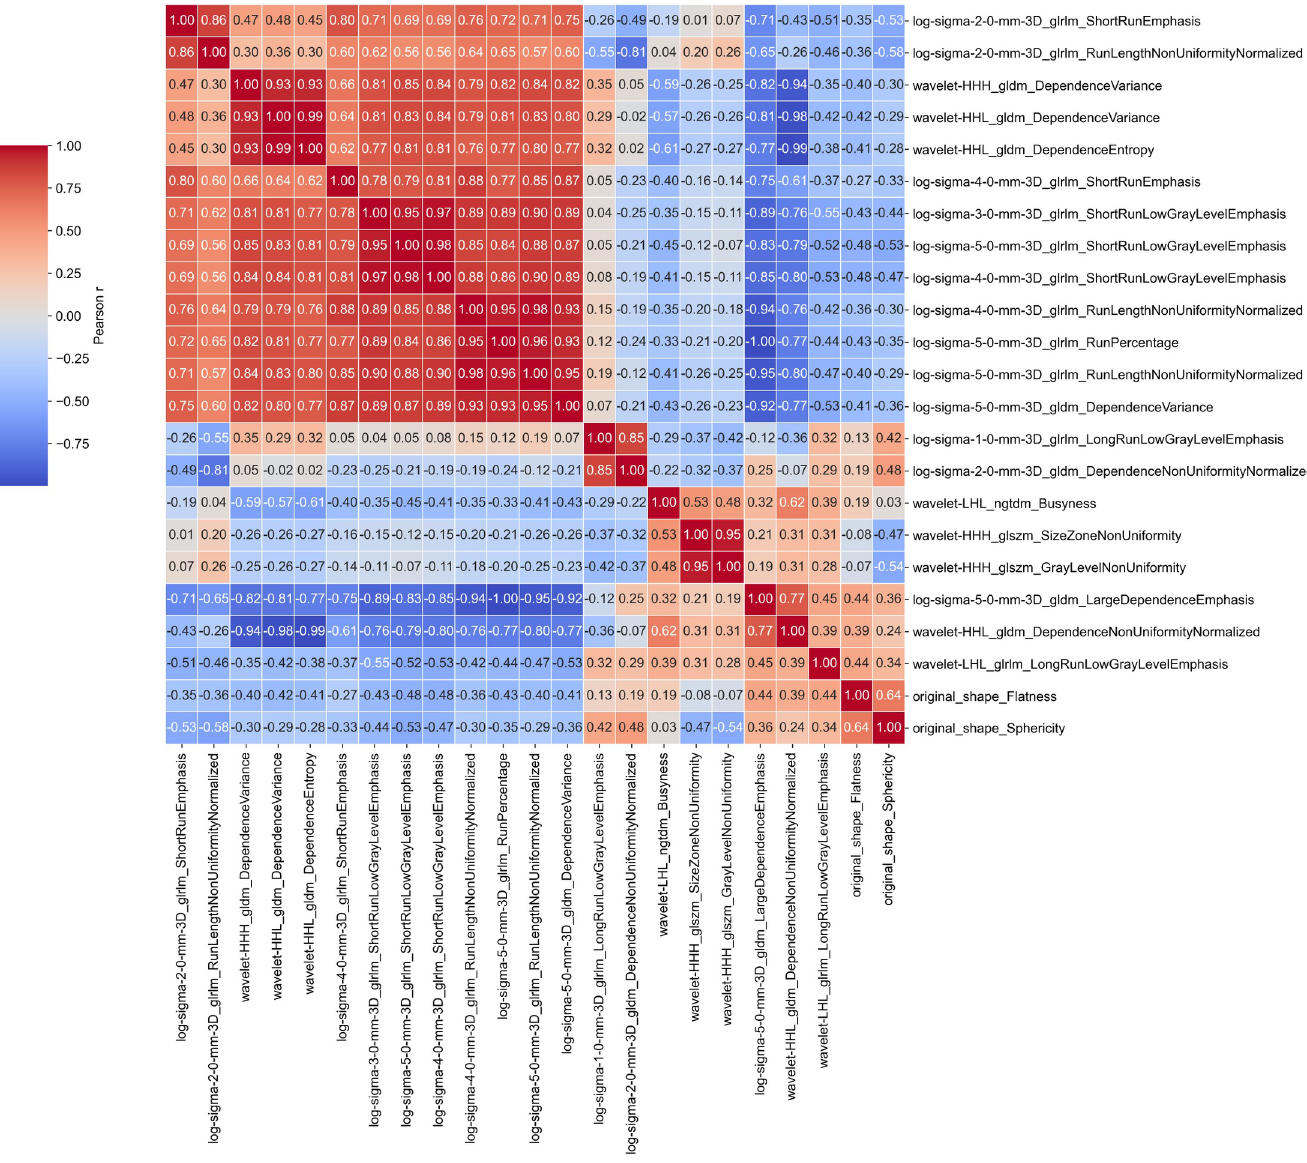
PLOS ONE | https://doi.org/10.1371/journal.pone.0261401 December20,